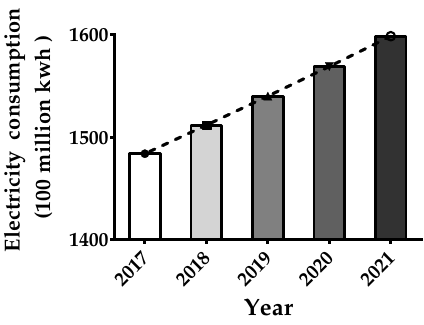
Figure 4. The predictive value of Shanghai’s electricity consumption from 2017 to